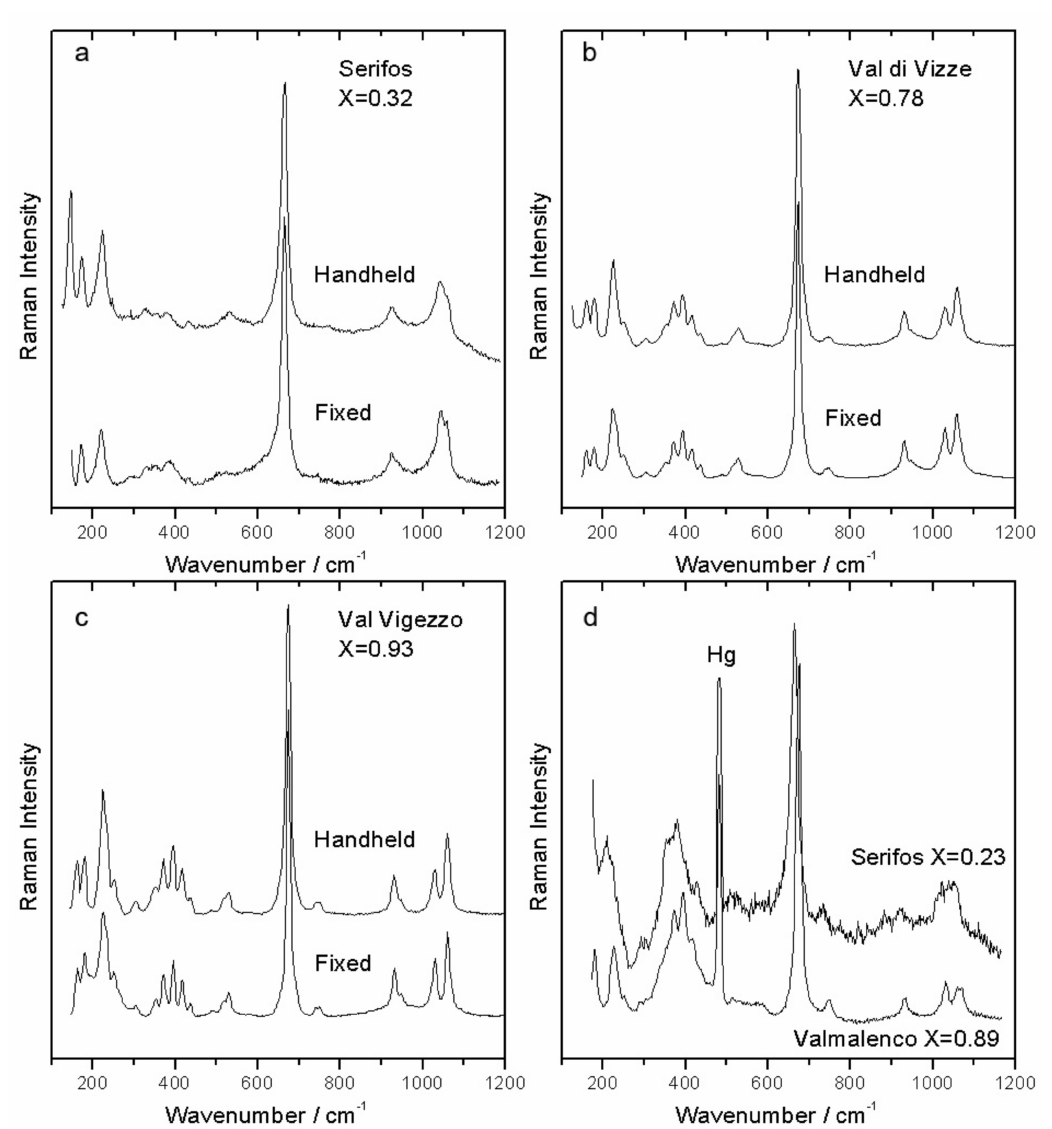
Figure 7. ( a – c ): comparison between spectra obtained on di ff erent samples in the low-wavenumbers region with fixed and handheld Raman spectrometers; ( d ): comparison between spectra obtained on Fe-rich and Fe-poor samples with the handheld spectrometer in the low-wavenumber region. Hg = Hg emission line of a fluorescent tube. The X values reported are obtained by micro-Raman (fixed Raman)